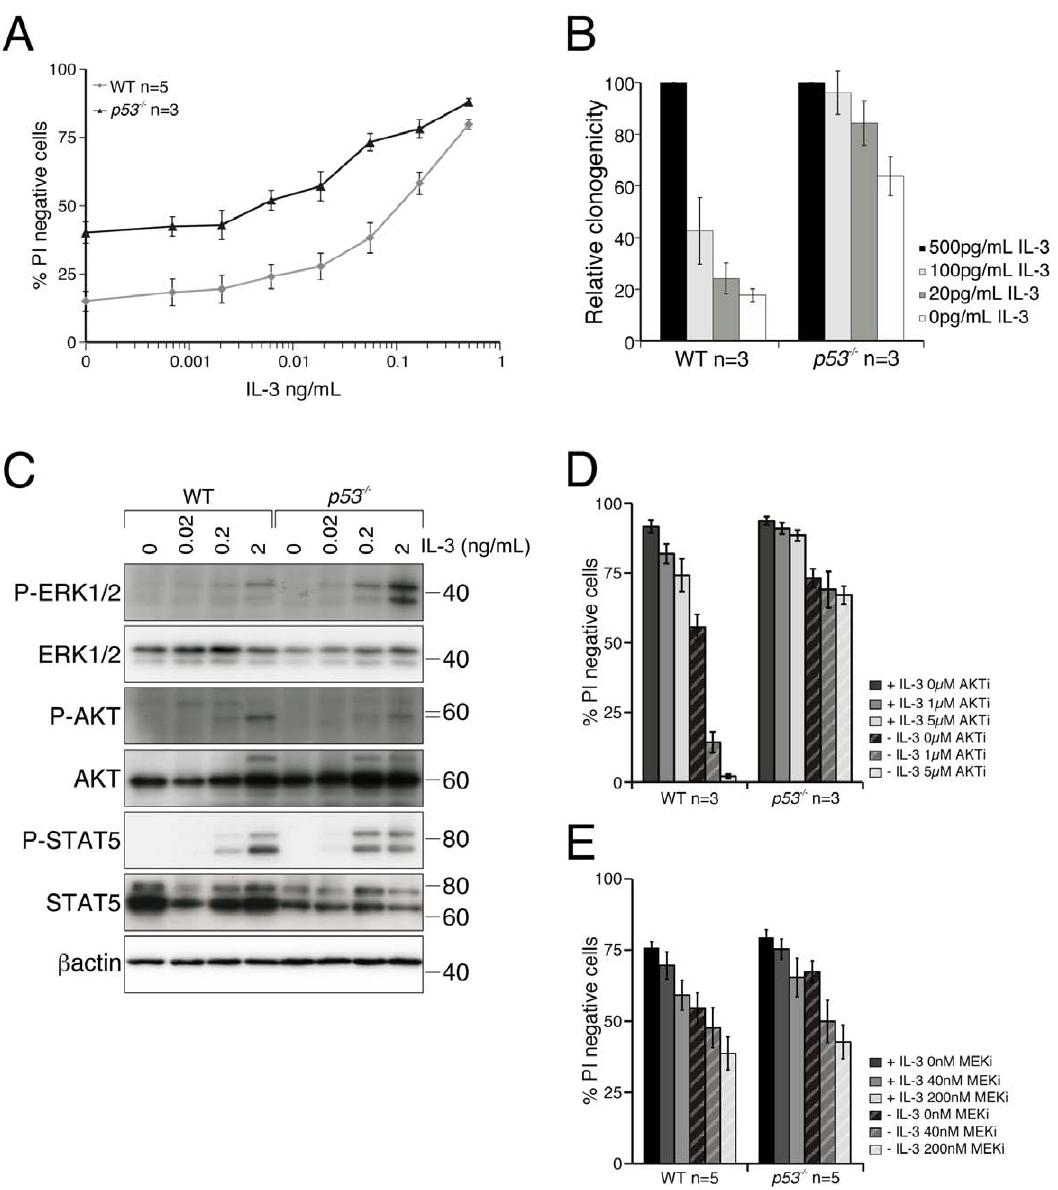
Figure 5. Analysis of the IL-3 signaling pathway in WT and p53 2 / 2 FDM cells. (A) Independently generated WT and p53 2 / 2 FDM cell lines (n=number of cell lines) were cultured in the indicated concentrations of IL-3 for 72 hours. Viability was determined using Propidium iodide (PI) exclusion detected by flow cytometry. Results show the mean + / 2 SEM of 3 independent experiments. (B) WT and p53 2 / 2 independent FDM cell lines (n=number of cell lines) were cultured in the indicated concentrations of IL-3 doses for 72 hours and then plated in soft agar with abundant IL- 3. The number of colonies was counted after 14 days and the clonogenicity (relative to the number of colonies generated in 500 pg/ml IL-3) calculated. Results show the mean + / 2 SEM of 2 independent experiments. (C) Lysates were generated from WT pr p53 2 / 2 FDM cells following stimulation with the indicated concentrations of IL-3 after 16 hours of IL-3 deprivation. Lysates were resolved by SDS-PAGE and immunoblotted with antibodies specific to the indicated proteins. (D) Independent WT and p53 2 / 2 FDM cell lines (n=number of cell lines) were treated for 24 h with an AKT inhibitor (AKTi) in the presence or absence of IL-3. Viability was determined by flow cytometric analysis of PI exclusion. Results show the mean + / 2 SEM of 2 independent experiments. (E) Independent WT and p53 2 / 2 FDM cell lines (n=number of cell lines) were treated for 24 h with a MEK inhibitor (MEKi) in the presence or absence of IL-3. Viability was determined by flow cytometric analysis of PI exclusion. Results show the mean + / 2 SEM of 4 independent experiments.